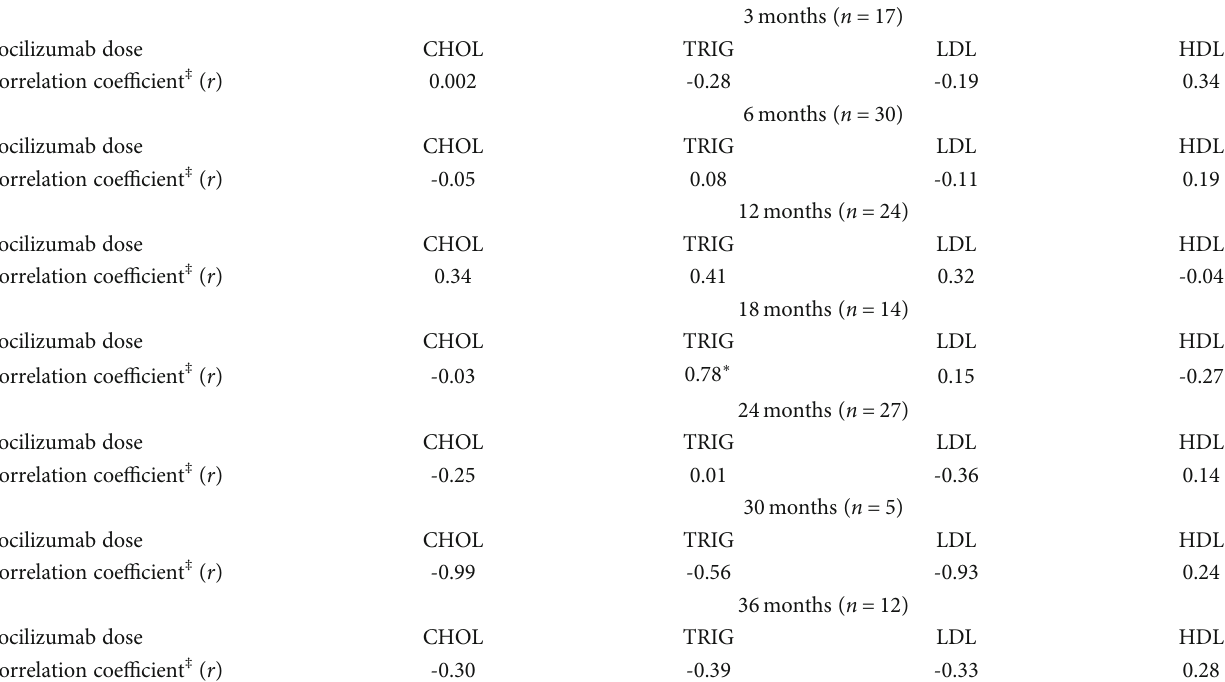
Table 6: Correlation between cholesterol and lipoprotein levels with tocilizumab dose, at di ff erent time